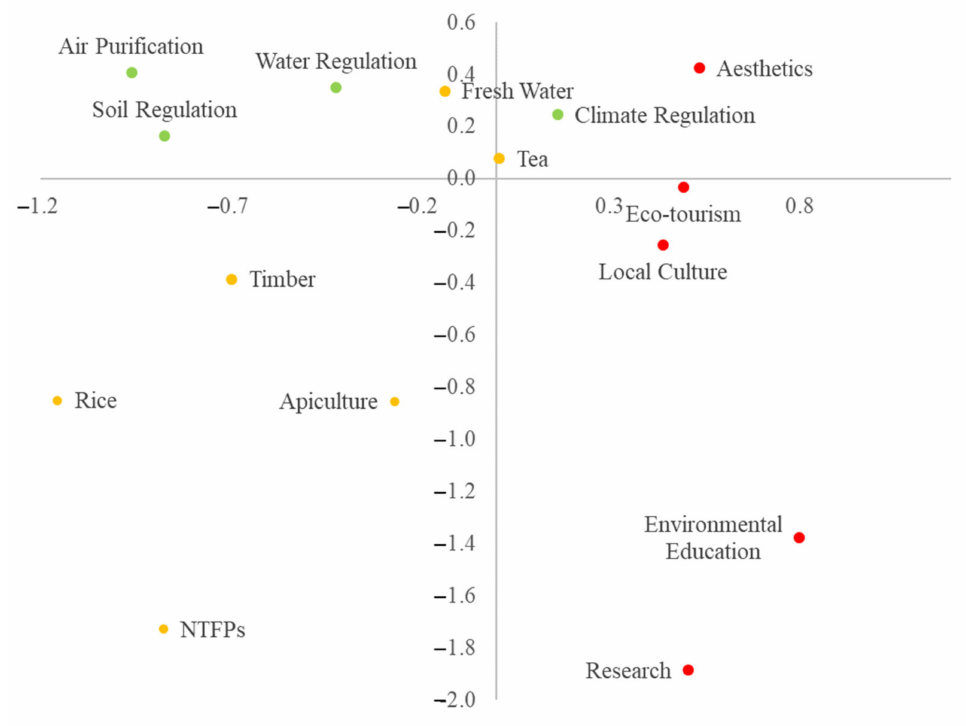
Figure 4. The MCA biplot of the preference of ES among tea farmers. Red: cultural services; yellow: provisioning services; green: regulating